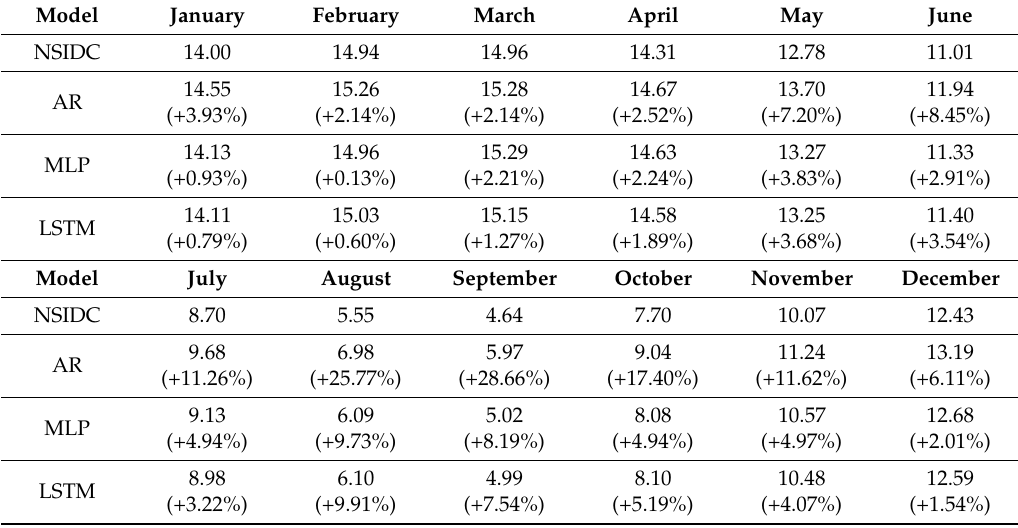
Table 7. Monthly Arctic SIE comparison between the actual observations and two prediction models in